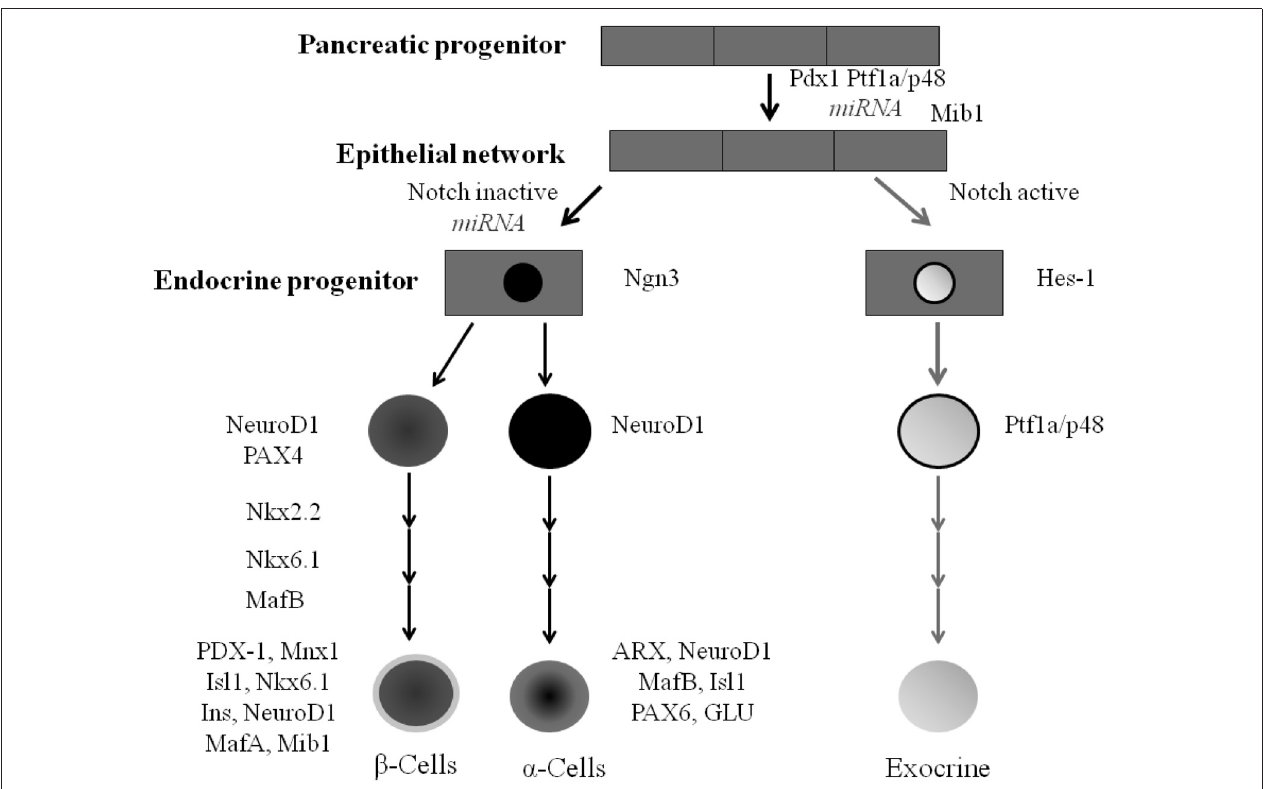
FIGURE 3 | Pancreatic cell lineage and the role of transcription factors during islet cell type development. All mature pancreatic cell types are derived from progenitors that express Pdx-1 and/or Ptf1a . Mnx-1 and Mib-1 act to regulate notch ligand activity. Ngn3 expression in pancreatic progenitor